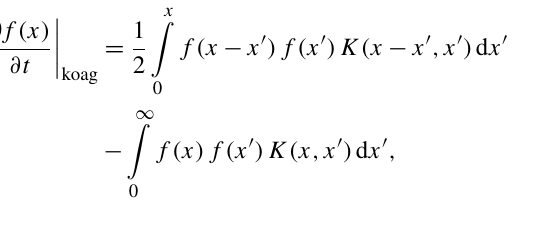
smaller than 80 µm radius, roughly a factor-of-2 increase from Re λ = 1000 to Re λ = 20 000 (Fig. 1a, b, c). For the